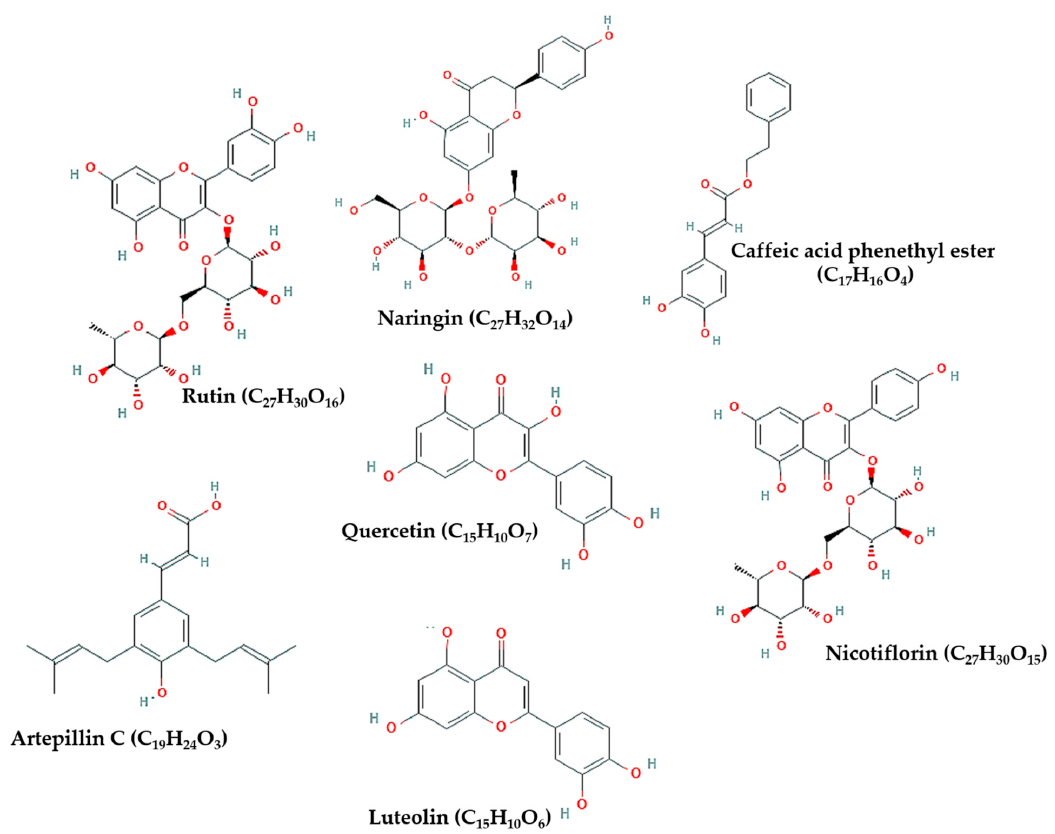
Figure 2. Chemical structure of flavonoids with the highest binding affinity to target proteins of severe acute respiratory syndrome-coronavirus-2 (SARS-CoV-2).